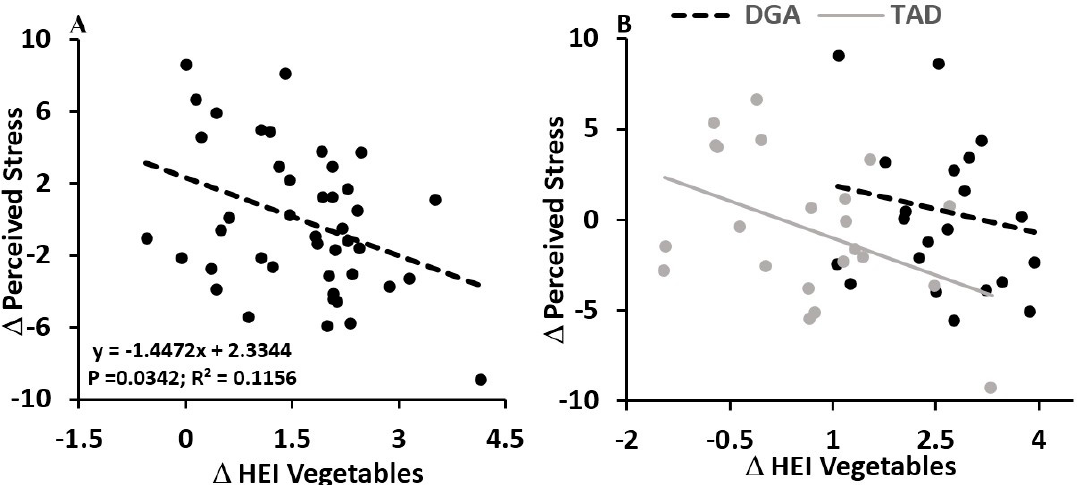
Figure 1. Independent of diet group, increasing the healthy eating index (HEI) for vegetable consumption associated with reductions in the 8 week perceived stress score ( A ). In the right hand figure ( B ), data and regression lines are presented for each diet group (DGA vs. TAD), showing that, for a given magnitude of delta HEI vegetables, the DGA group had a higher magnitude of perceived stress change. No statistical interaction between diet group and change in HEI vegetables was observed ( p = 0.5062), suggesting the regression slopes between DGA and TAD groups were not different, with both demonstrating an inverse association between delta HEI vegetables and delta perceived stress. Data and regression lines presented in A and B were statistically adjusted for age, education, BMI, and pre-intervention perceived stress score.